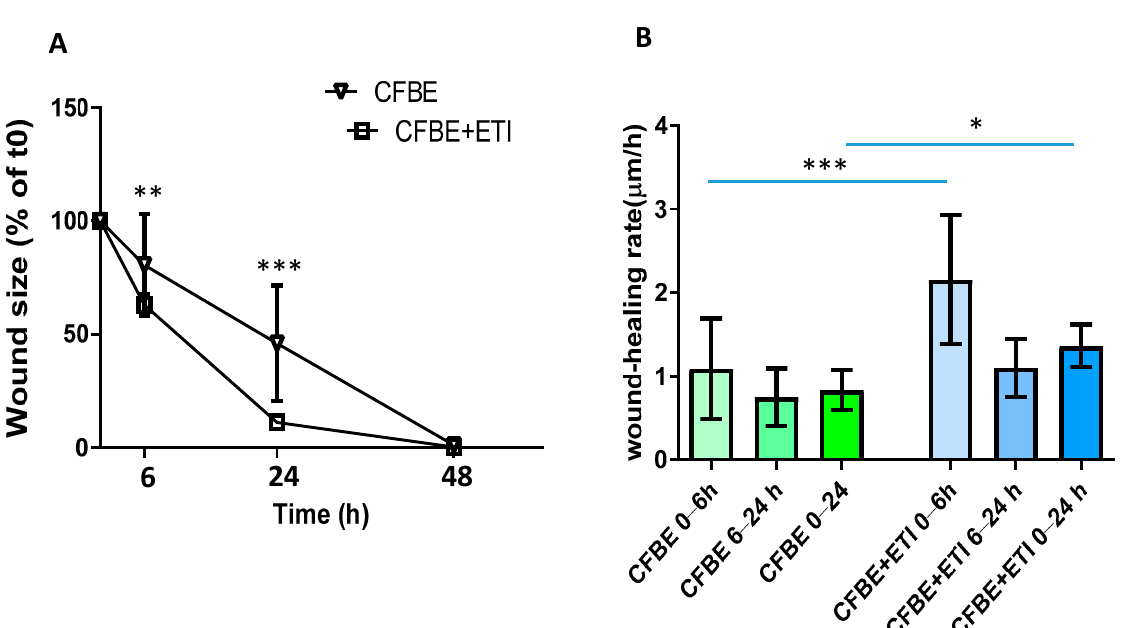
Figure 3. Wound size and wound healing rates in the presence of elexacaftor/tezacaftor/ivacaftor (ETI). ( A ) Percentage of wound size after 6, 24 and 48 h. Data are represented as a percentage of the initial area of the wound (t0) considered 100%. ** p < 0.01 and *** p < 0.001 CFBE-F508del + ETI vs. CFBE-F508del at 6 and 24 h, respectively ( n = 3). ( B ) Comparison of wound closure rates post wounding ( n = 3). * p < 0.05; *** p < 0.001. Data are shown as mean ± SD.